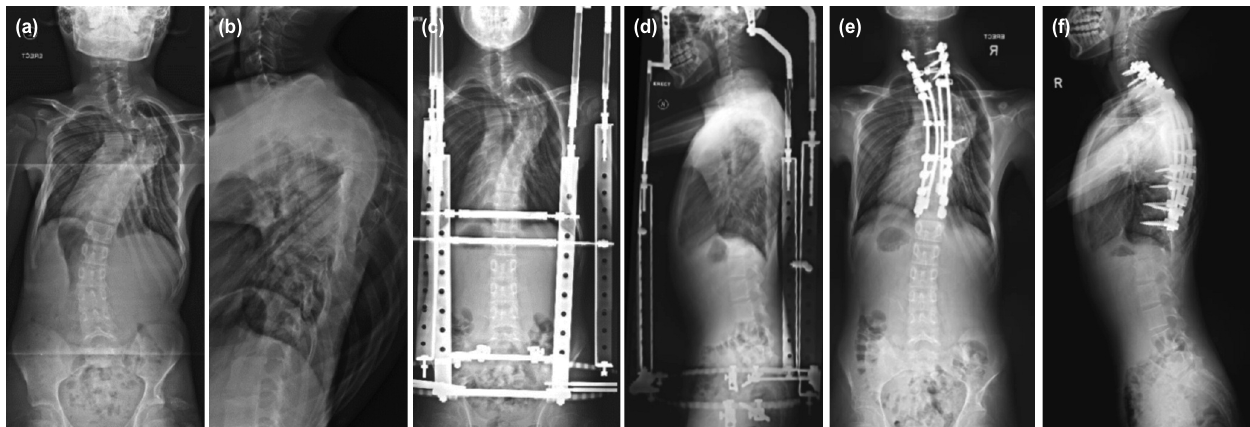
Plain radiographs (posteroanterior and lateral view) of Case 3: (a, b) before operation, (c, d) while on halo-pelvic traction, and Fig. 3: (e, f) after single-stage posterior spinal